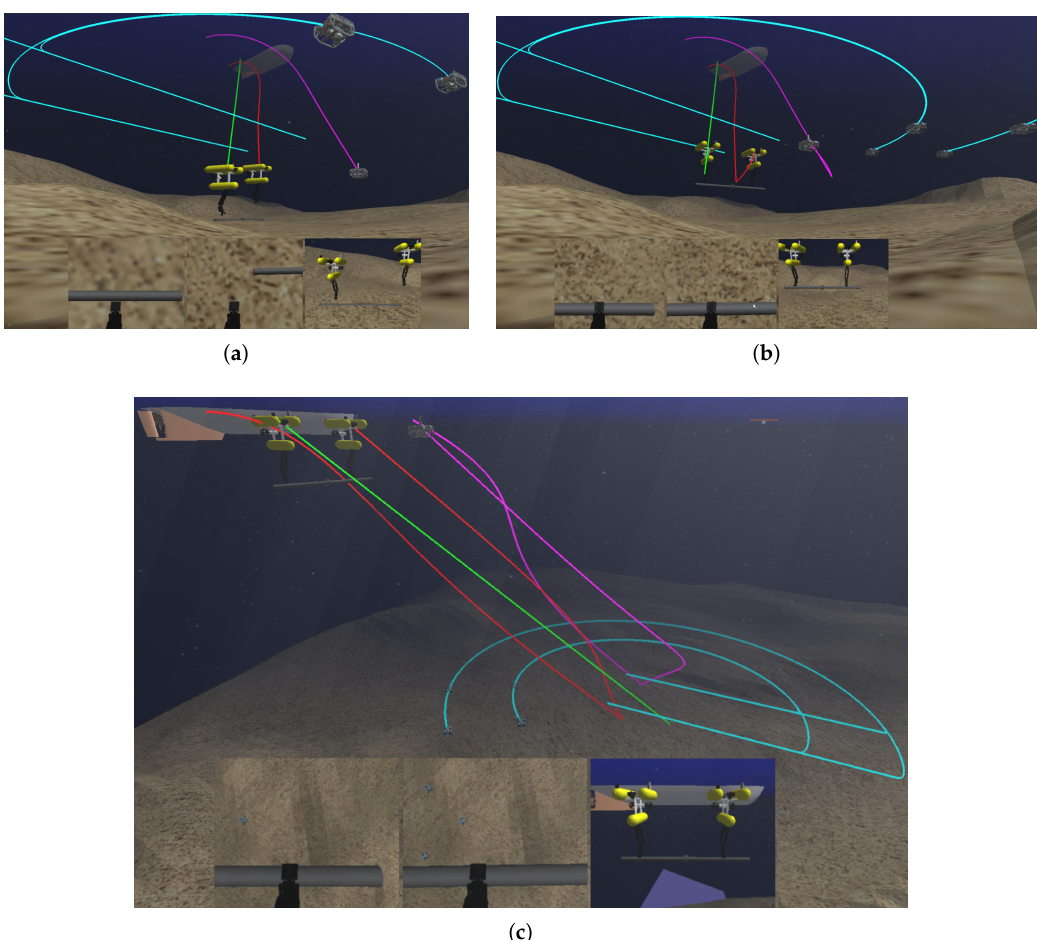
Figure 6. Trajectories followed by the ROVs during the experiment. The trajectories of the explorers are represented in white lines. The lines in yellow and red correspond to the trajectories of the two I-AUVs, and the line in magenta corresponds to the support ROV. Each image corresponds to a different stage of the experiment: ( a ) approaching; ( b ) cooperative grasping; and ( c )